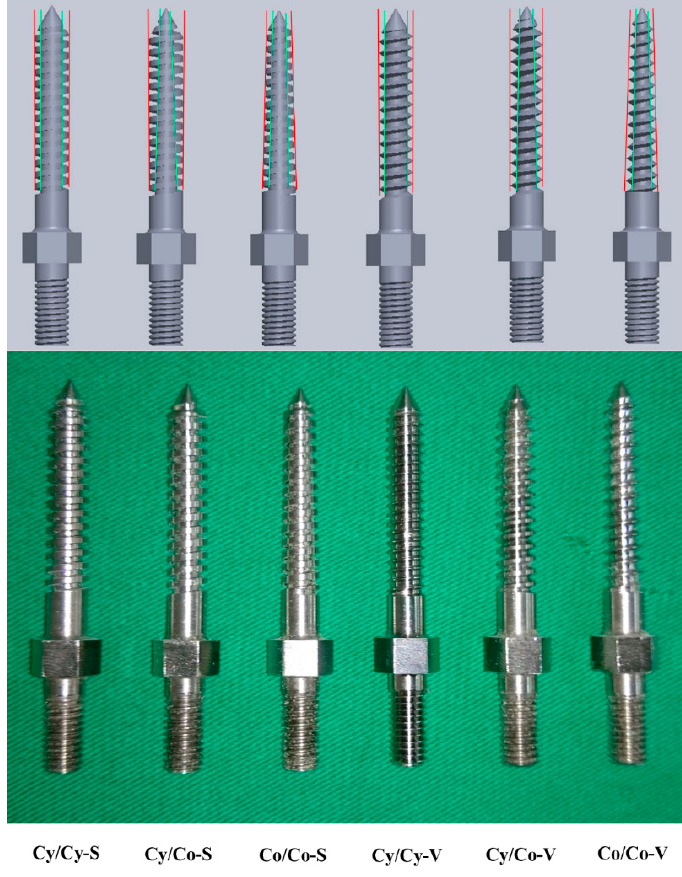
Figure 2. Schematic drawings ( upper ) and photographs ( bottom ) of six types of pedicle screws with different outer/inner projections (Cy/Cy, Cy/Co, Co/Co) and thread profiles (square-shaped and V-shaped).